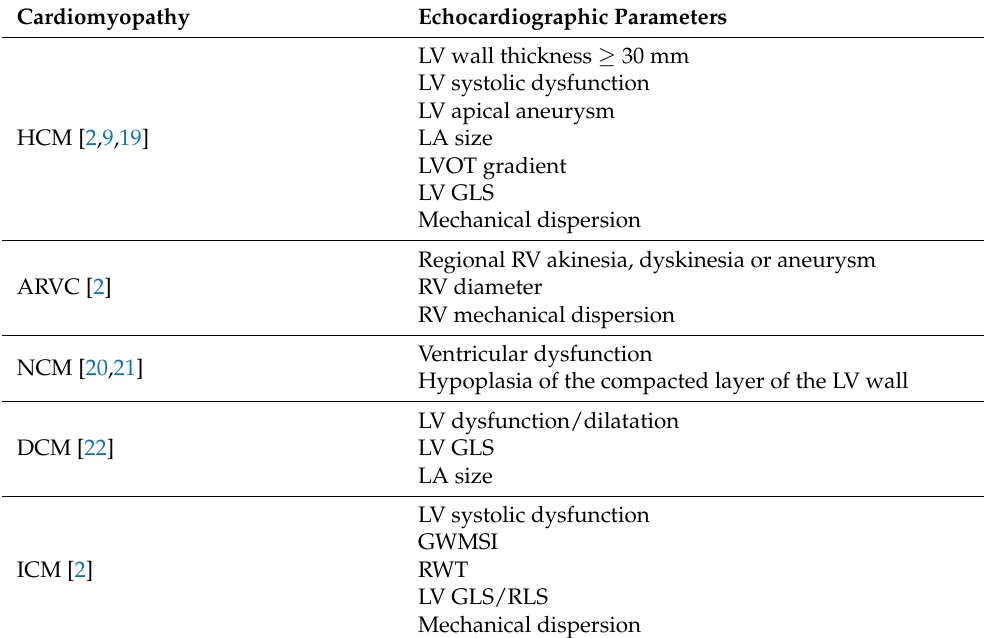
Table 3. Echocardiographic arrhythmogenic risk stratification in structural heart disease. Cardiomyopathy Echocardiographic